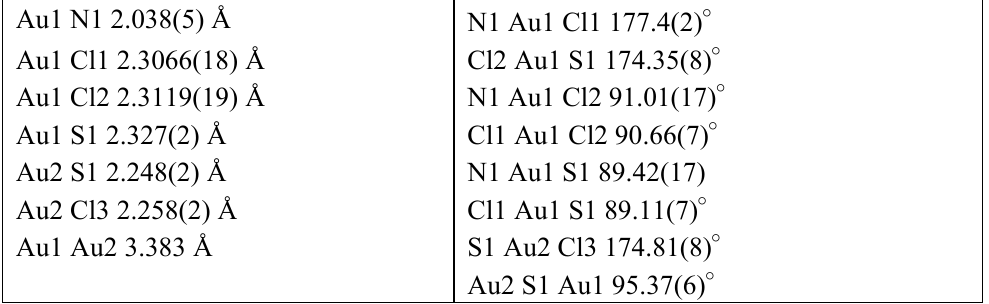
Table 1. Selected bond distances (Å) and angles (°) in species 8